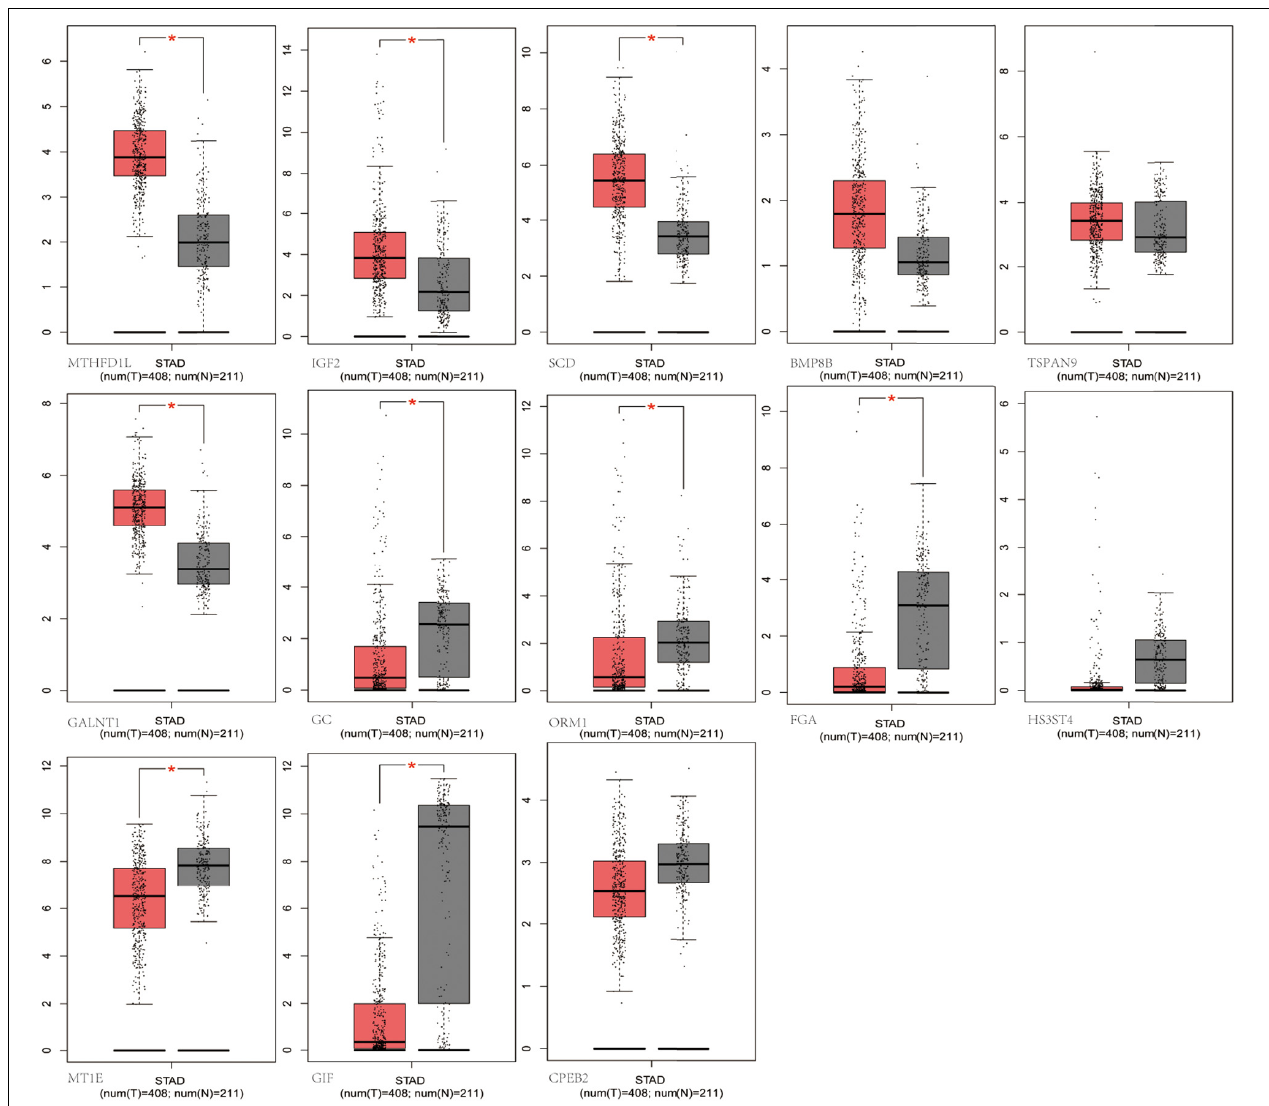
FIGURE 8 | Validation of the differentially m6A related expressed genes. MTHFD1L, IGF2, SCD, GC, ORM1, FGA, GALNT1, MT1E, and GIF had significant differences ( P <